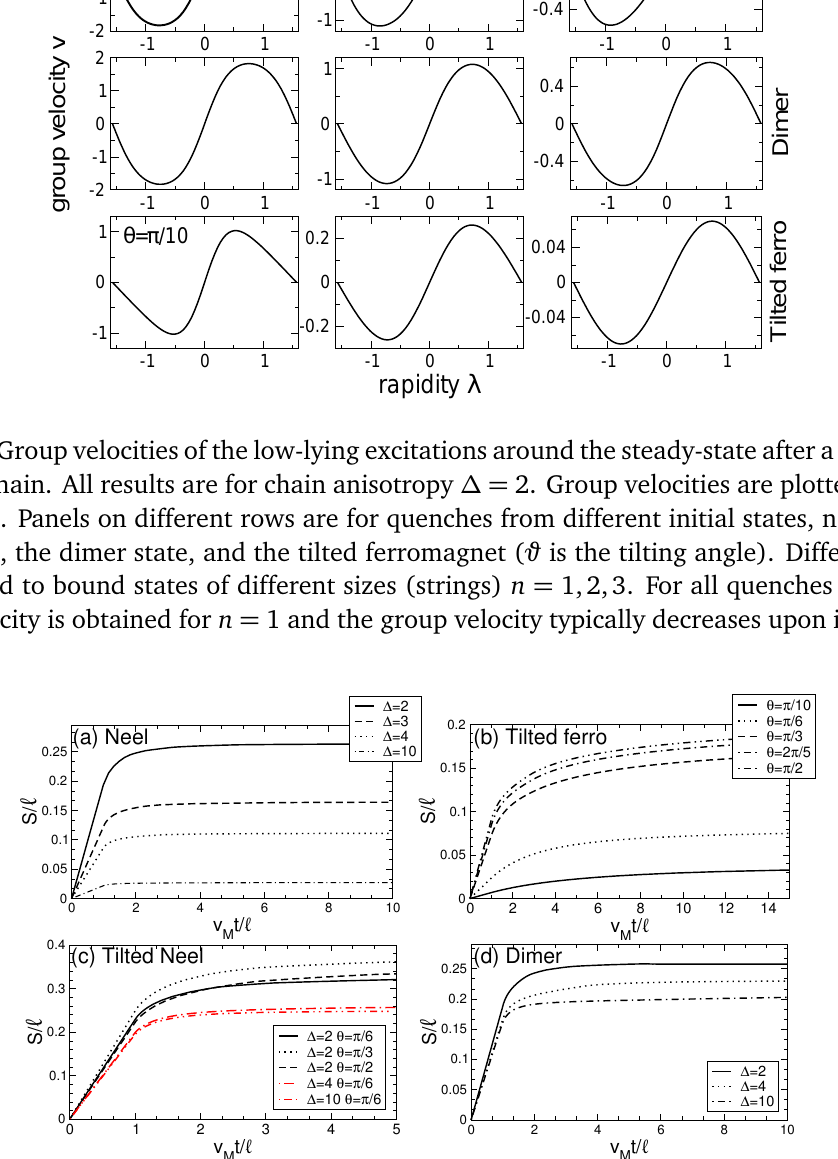
Figure 4: Quasiparticle prediction for the entanglement dynamics after a global quench in the XXZ chain. In all panels the entanglement entropy density S /(cid:96) is plotted against the rescaled t /(cid:96) , with (cid:96) the size of A and v time v the maximum velocity. Different panels correspond to M M different initial states, namely the Néel state (a), tilted ferromagnet (b), tilted Néel (c), and dimer state (d). Different curves correspond to different values of the chain anisotropy ∆ > 1 and tilting angles ϑ